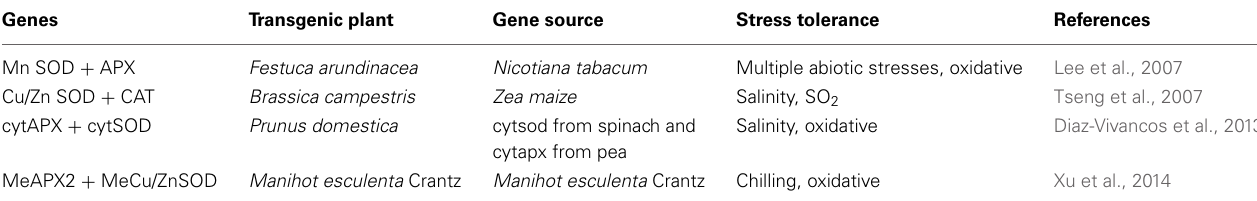
tolerance to various abiotic